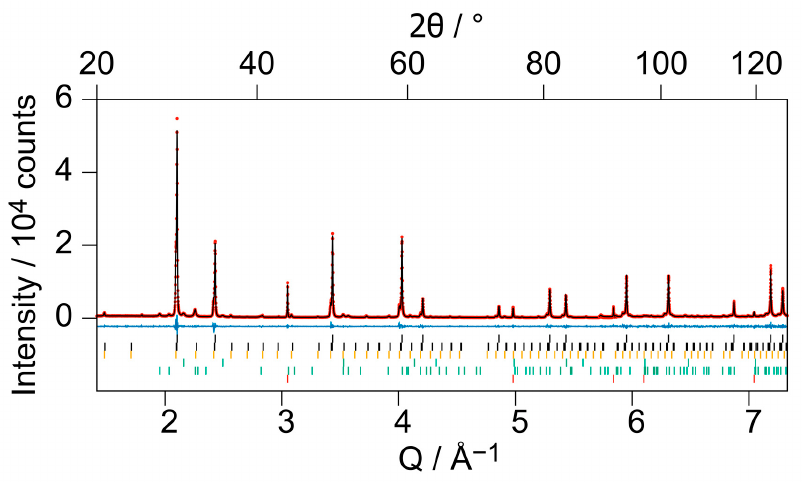
Figure A1. Rietveld refinement of the crystal structure of cubic LuHO obtained from Lu 2 O 3 and LuH 3 on the basis of X-ray diffraction data at ambient temperature ( λ : Cu- K α 1 ). R wp = 6.97%, GoF = 1.97. Bragg markers denote from top to bottom: LuHO F 43 m (68.6(5) wt%, R I = 0.5%, a = 5.171591(13) Å), LuHO Pnma (4.24(13) wt%), Lu 2 O 3 Ia -3 (17.59(24) wt%, a = 10.39605(11) Å), LuH 2 Fm 3 m (2.92(8) wt%, a = 5.0367(5) Å), LuH 3 P 3 c 1 (6.60(11) wt%, 6.1727(4) Å, c = 6.4257(6) Å), diamond (added to re- duce X-ray absorption). Red dots: measurement meas , black curve: calculation calc , blue curve: difference meas-calc .